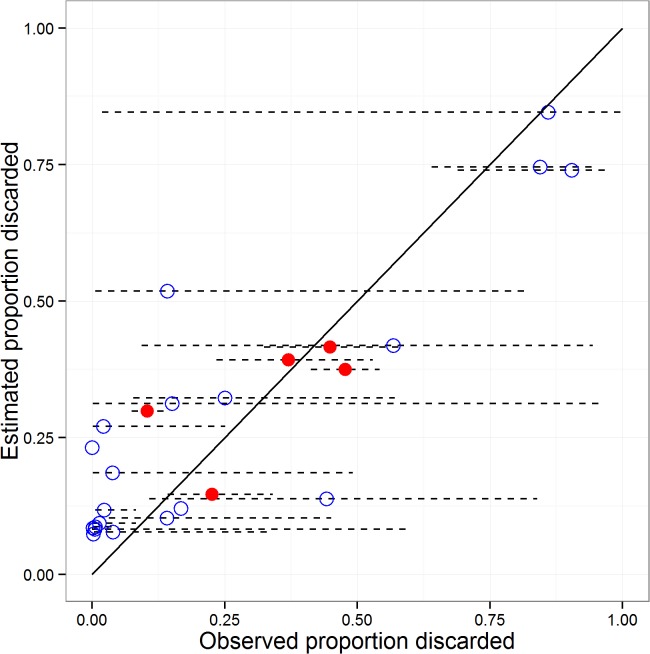
Comparison of modelled and observed proportions discarded.Mean observed proportions of catch discarded from the ICES data in the case of the reference species (averaged over 2001–2010), and from fragments of data harvested from the literature in the case of all other species (S3 Table). Estimated proportion discarded averaged over 2001–2010 from the reduced model in all cases. Horizontal dashed lines indicate ± 1 s.d. of logit transformed observed data. Red circles: reference species; blue circles: all other species. Black line indicates the 1:1 relationship.